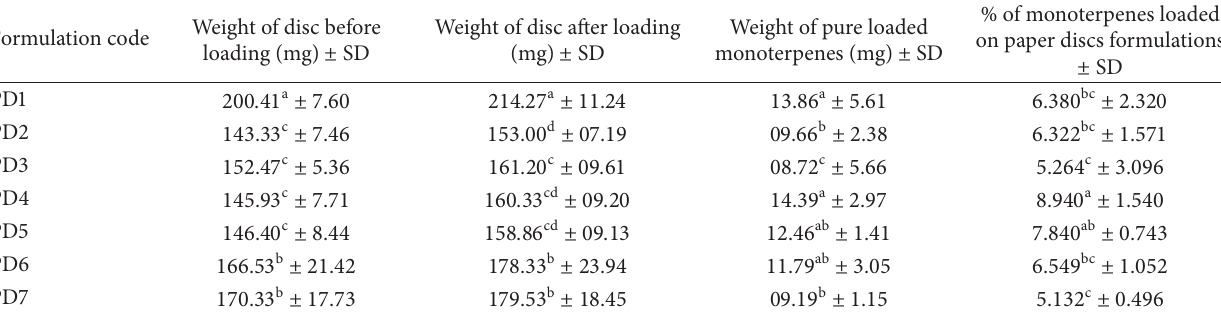
Figure 5: Fumigant assay of paper discs against mosquito adults (a) and knockdown assay of monoterpenes incorporated on wax (b). Table 1: Properties of paper discs impregnated in mixtures of